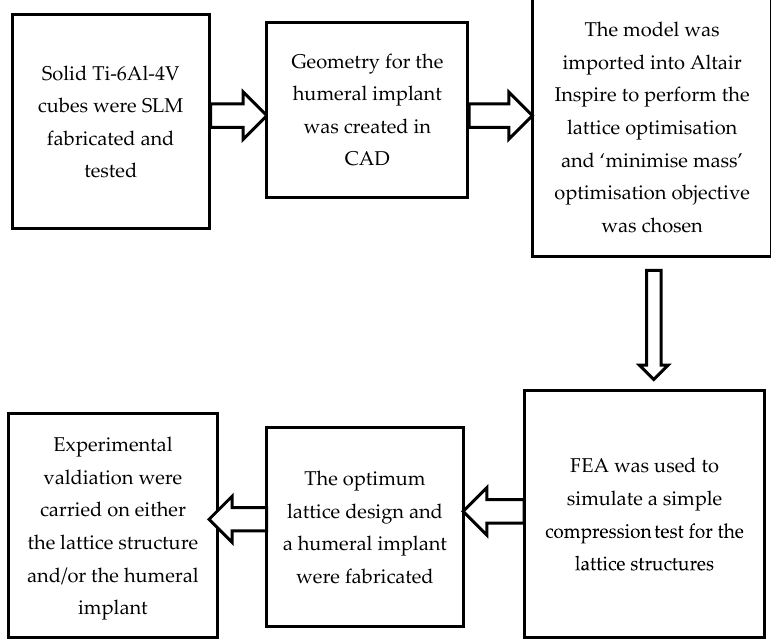
Figure 6. Workflow of performed computational and experimental testing in the current study.